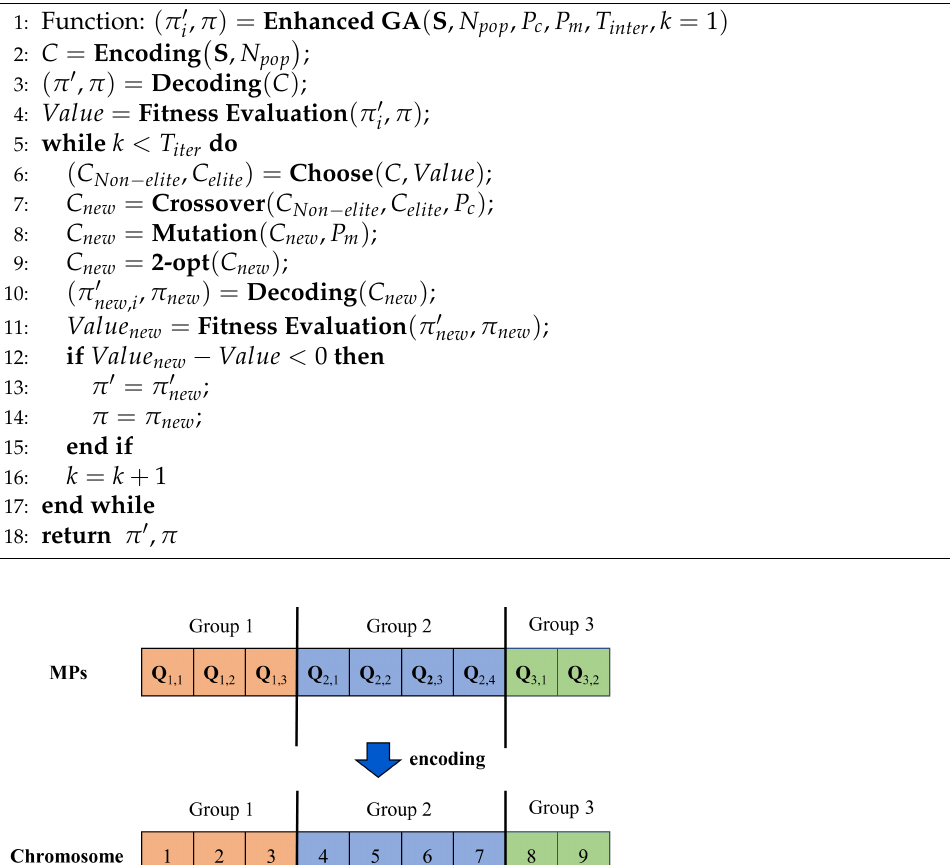
Algorithm 5 Optimize global path via enhanced GA